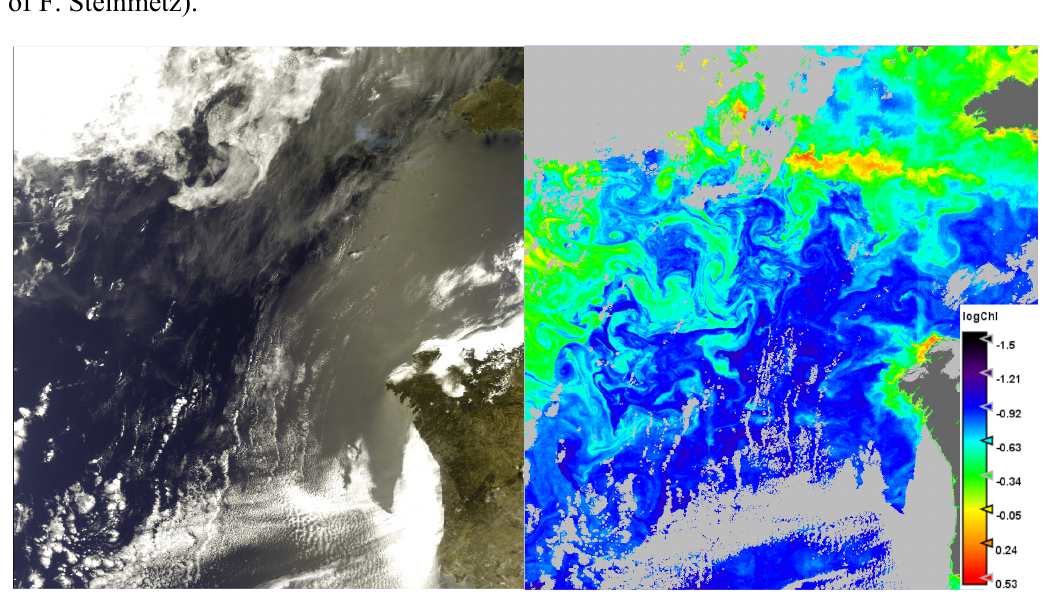
Figure 3. MERIS false color image acquired off the coast of Portugal on 21 June 2005 ( left ) and chl- a concentration derived by the POLYMER algorithm ( right ). The algorithm was able to retrieve chl- a concentration in the presence of thin clouds and sun glint (Courtesy of F.